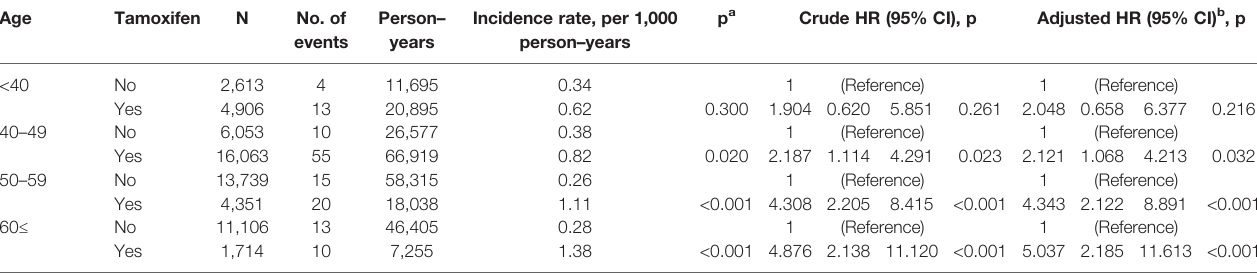
TABLE 2 | Univariate analysis and multivariable Cox regression analysis of endometrial cancer risk related to tamoxifen by age at